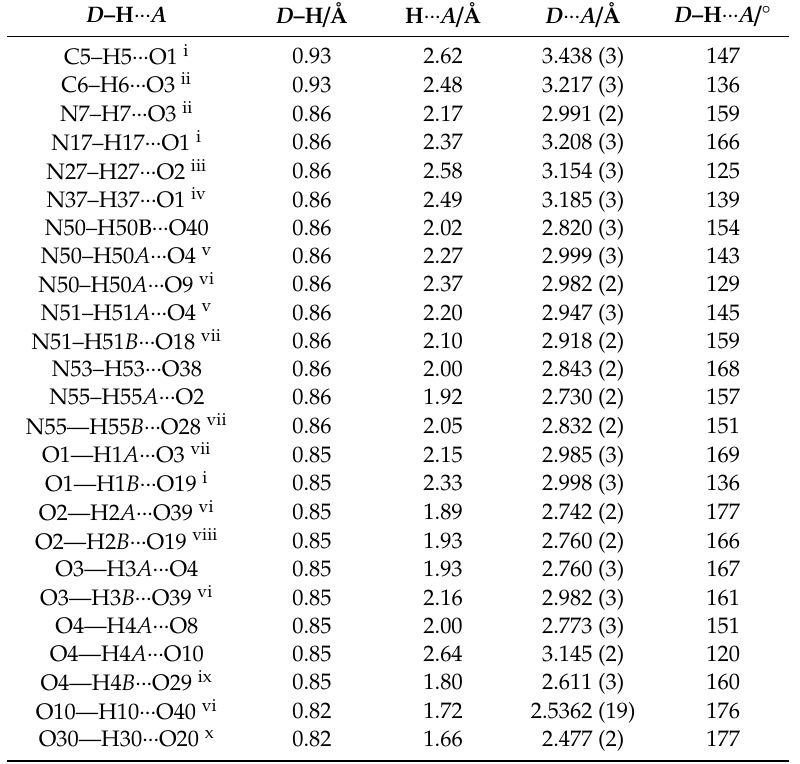
Table 3. Intermolecular hydrogen bonding geometric parameters of H 2 Mf(HpOXA) 2 ·